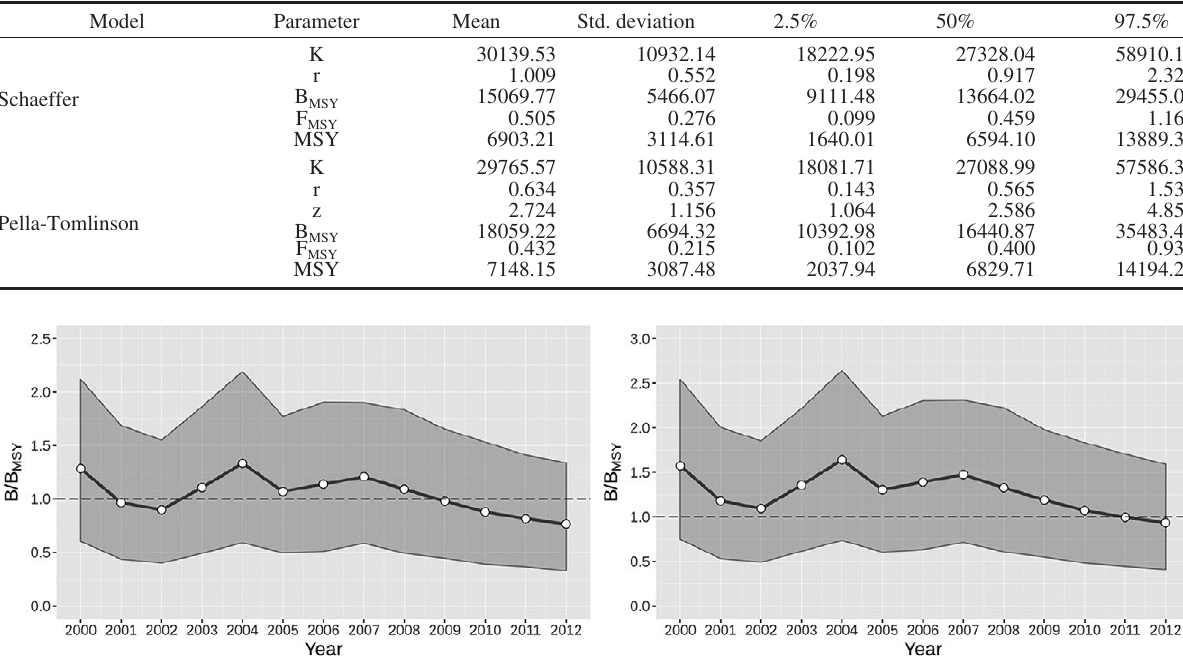
/B ) for two Bayesian state-space t MSY